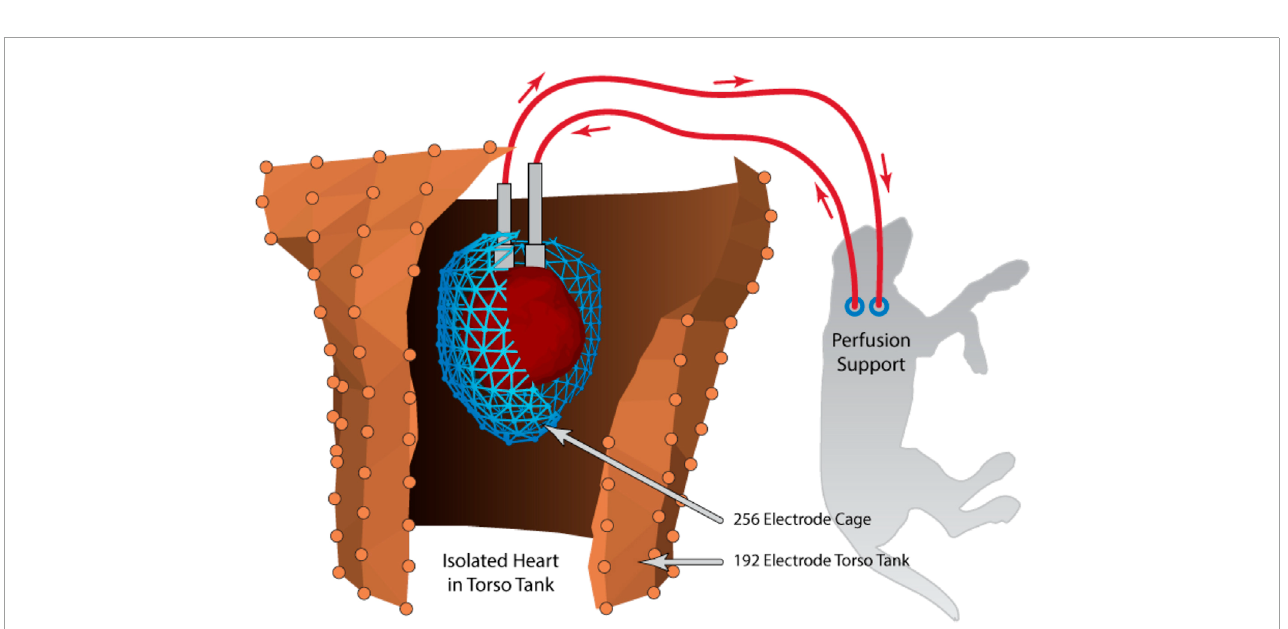
FIGURE 4 Schematic example of the torso tank preparation that includes an isolated heart, suspended in the human shaped torso tank and perfused by a secondary animal. Recording arrays shown are the pericardiac cage array (blue) surrounding the isolated heart and torso tank array (brown). Reprinted from Bergquist et al. (2021) Copyright 2021, with permission from